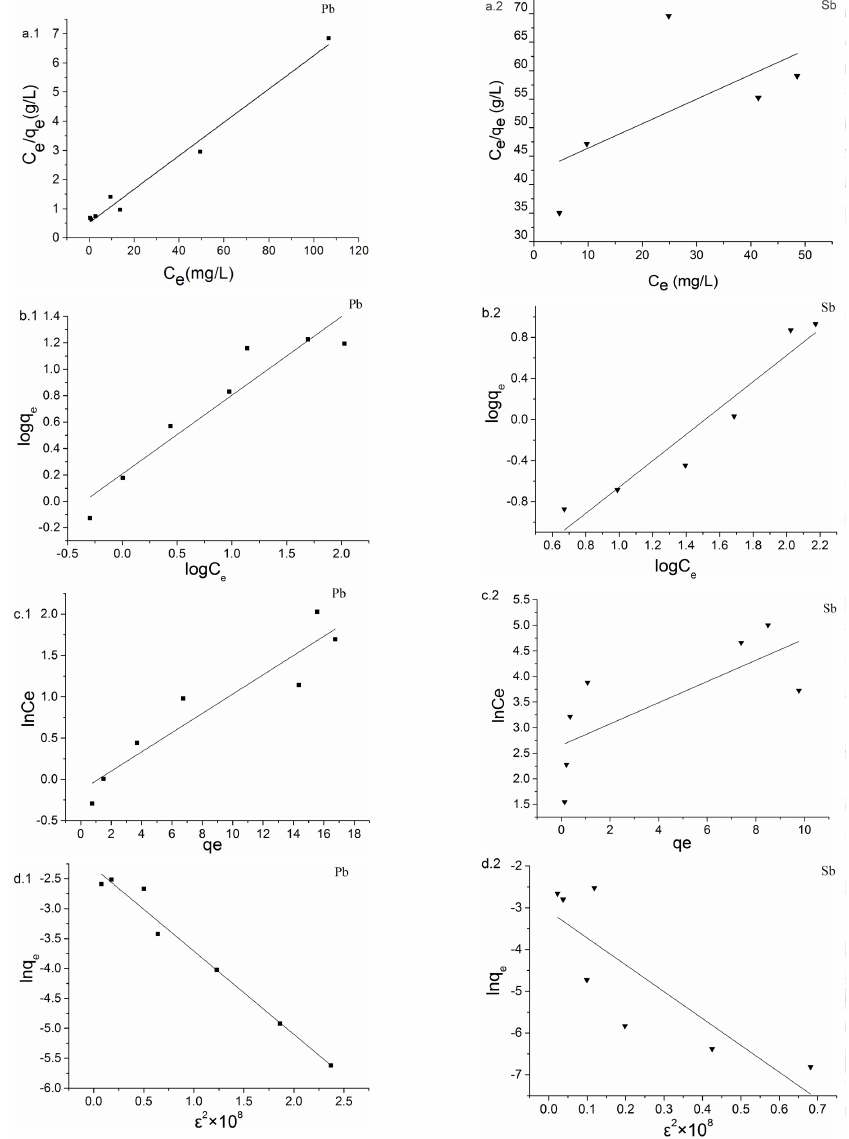
Figure 3. Langmuir ( a ), Freundlich ( b ), Temkin ( c ) and D-R ( d ) isotherm plots for the biosorption of Pb(II) and Sb(III) ions onto B. subtilis (pH: 5.00, biomass dosage: 6.00 mg/L, temperature: 35 ◦ C; contact time 45